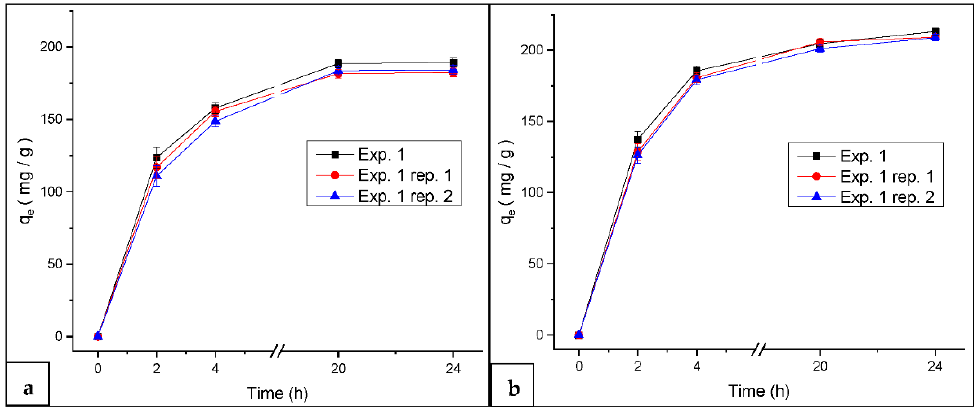
Figure 4. MB adsorption as a function of time at pH 6.0 and 37.5 ◦ C using ( a ) SAP and ( b ) SAP-AC as